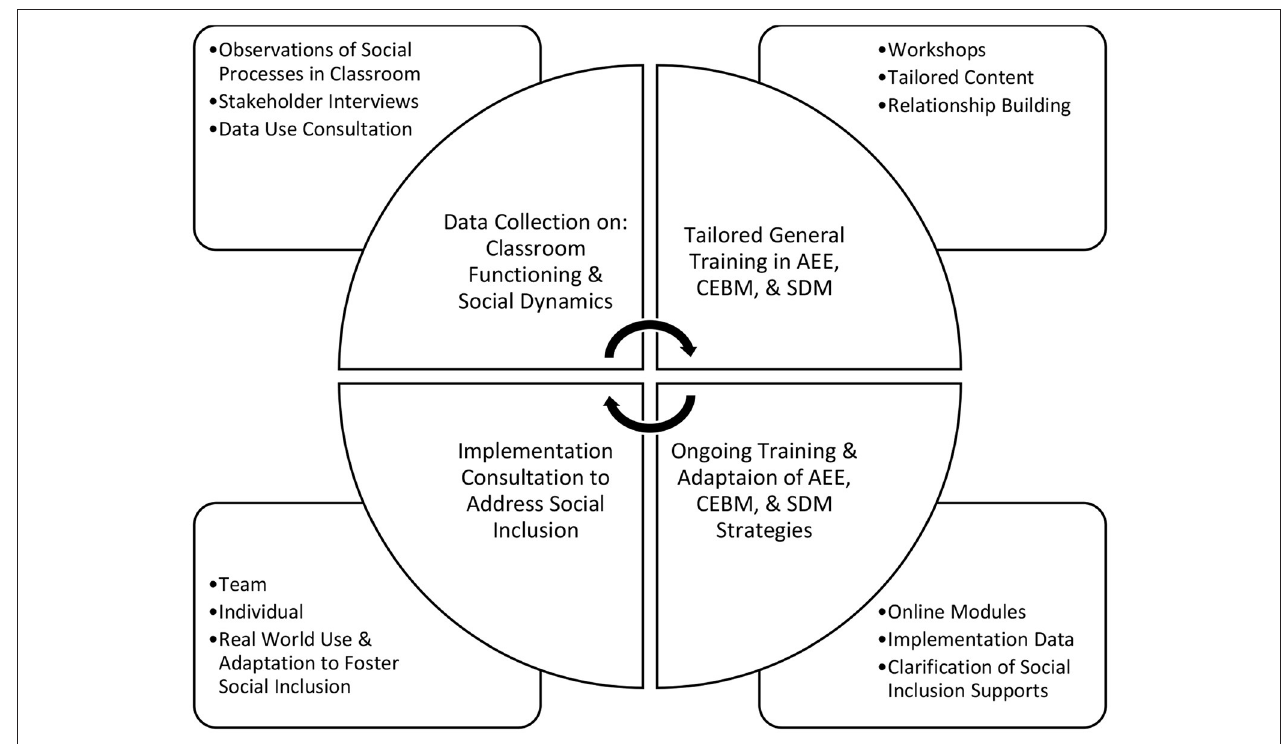
FIGURE 1 | The directed consultation process to facilitate social inclusion with the BASE